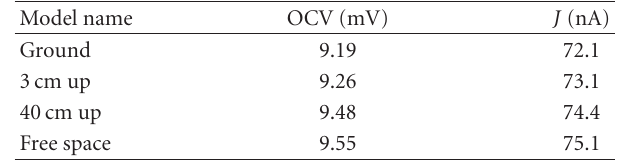
Table 1: Input power and input impedance of the transmitter. Table 2: OCV and current of the